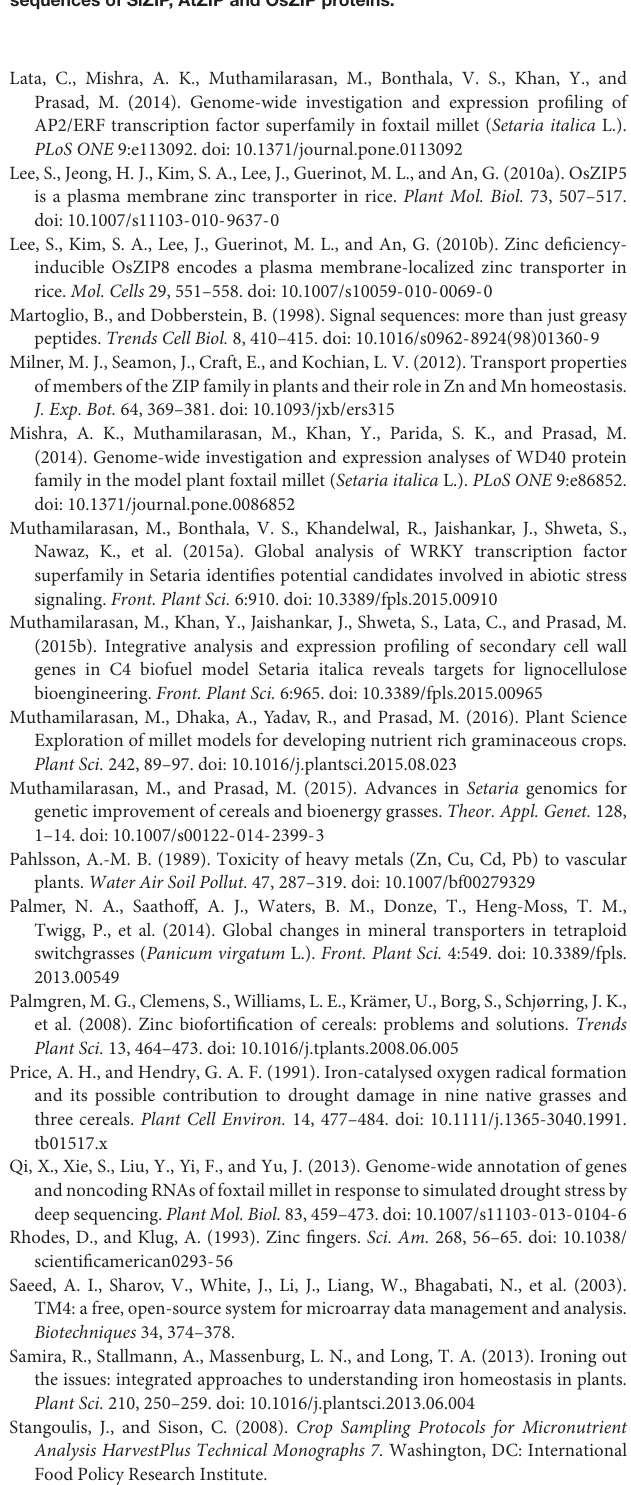
FIGURE S4 | Membrane topology of ZIP proteins across rice, Arabidopsis and foxtail millet. Red color amino acids represent signal peptides of respective